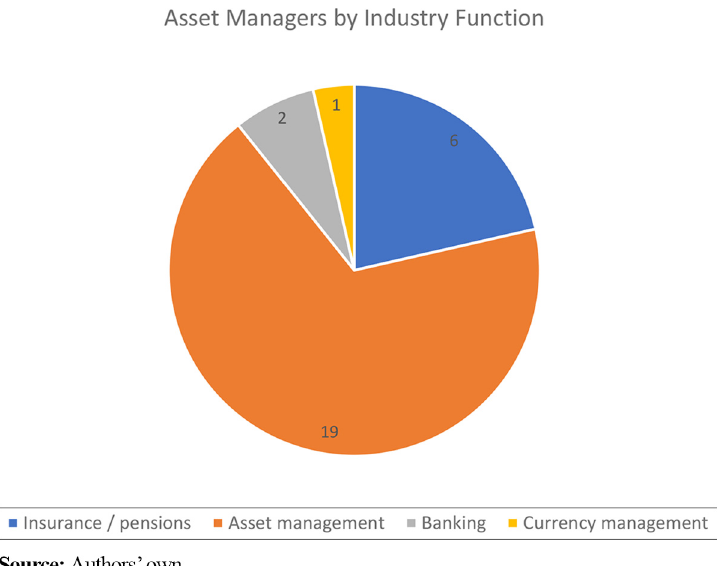
Figure 4. Proportion of asset managers within single-service, group or parent